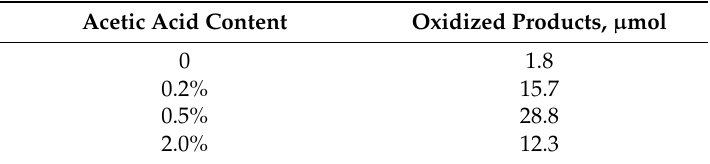
Table 1. Yield of photolysis products after 20-min irradiation (100 W Hg lamp, ( λ > 360 nm) of 1.0 mL of cyclohexane with 20 mg of Et 4 N[FeCl 4 ].